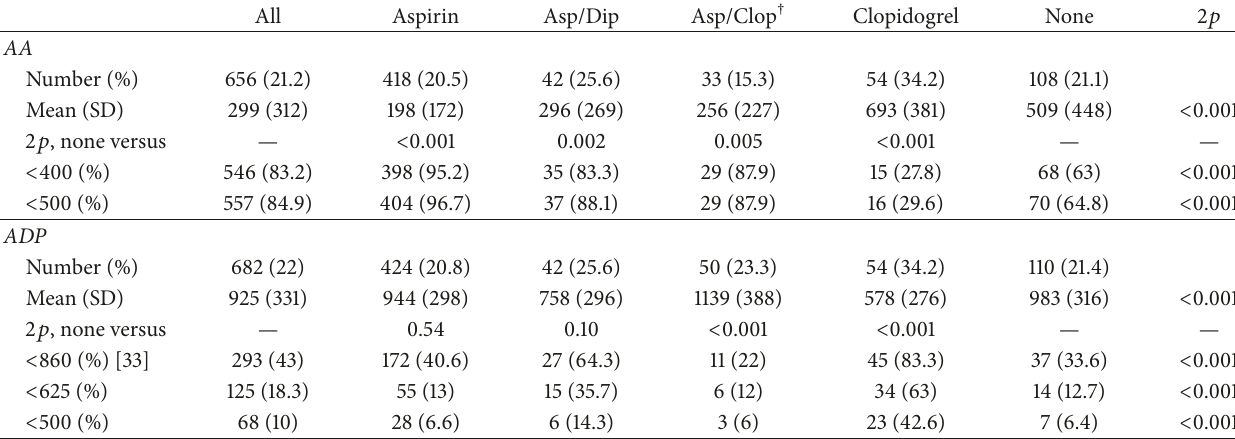
One patient on triple antiplatelet therapy (ADP 487 IU, AA 161 IU) and one patient on dipyridamole alone (ADP 1562IU) (protocol violations) are excluded. † Protocol violation